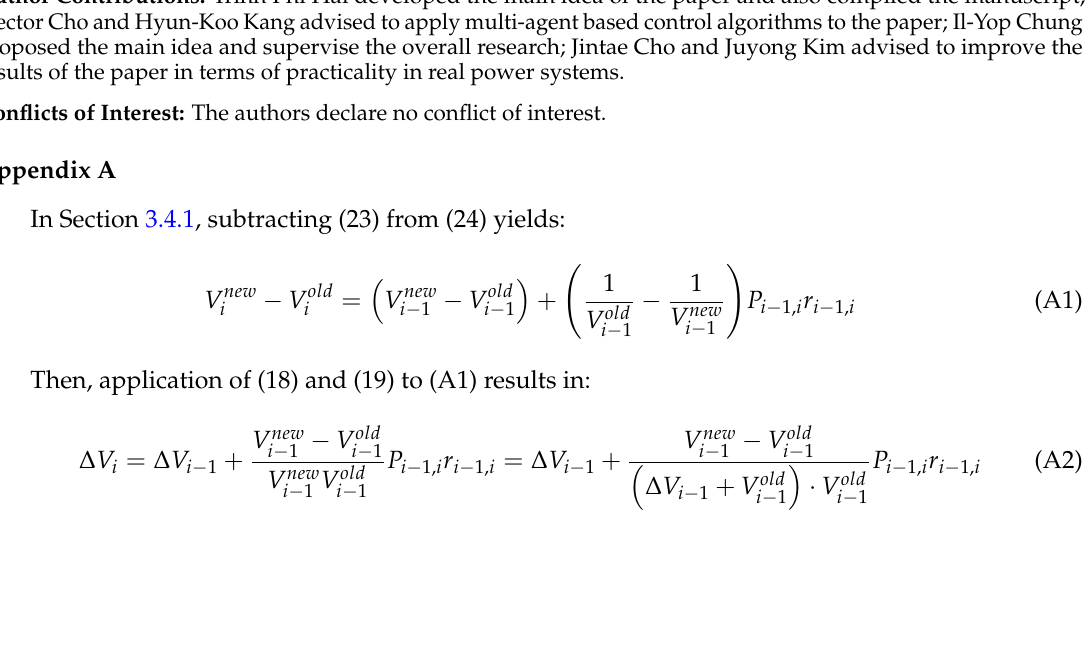
Figure 13. Power injection of the selected DER comparing the conventional and proposed methods.